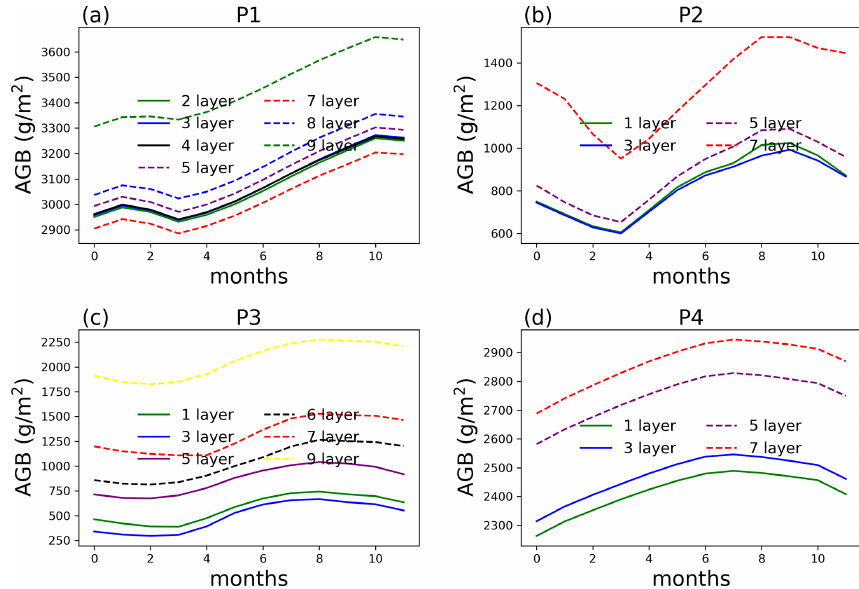
Figure 7. AGB from single-point simulations at each selected location (P1–P4) at year 10 of the